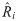
Number of daily new cases and the reproduction number R^i estimated using the
state-space method.France, Australia, Iran, and Brazil.